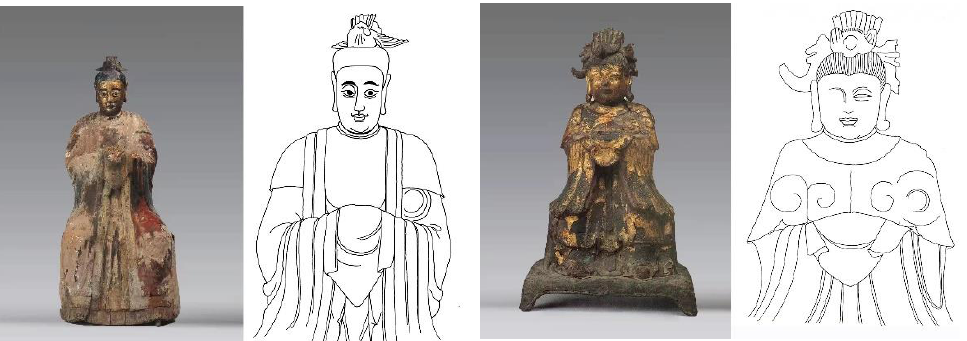
Figure 9. Mazu statue in Zhenlan Palace, Dajia, Taiwan. Source: Photographed and drawn by the author.